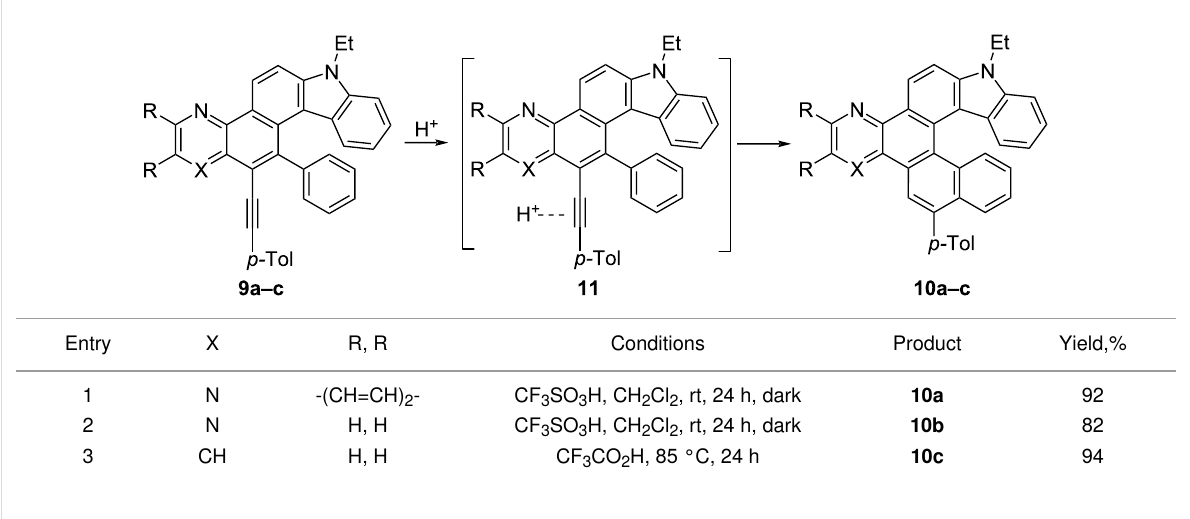
Table 5: Acid-induced isomerization of compounds 9 into carbazole-based [6]helicenes 10 .